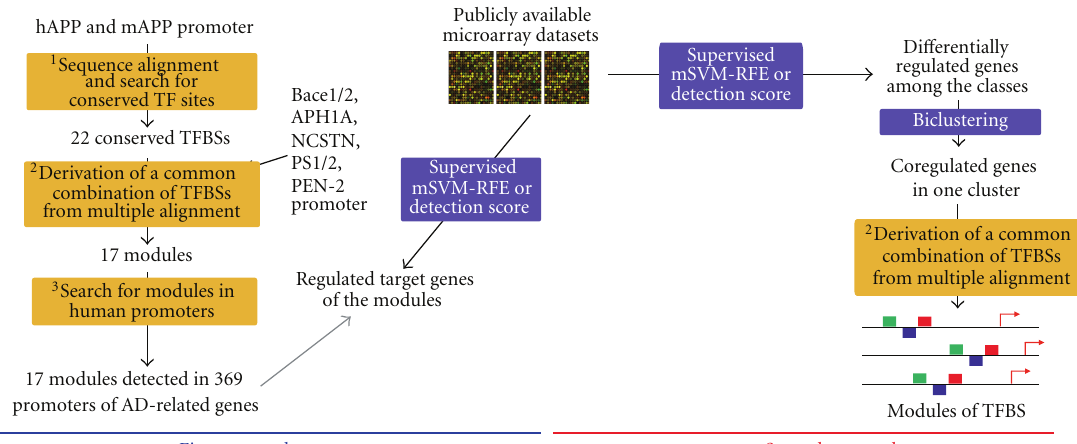
Figure 1: Workflow of bioinformatics analysis of promoter sequences and gene expression data to identify modules of TFBSs in AD-related genes. The workflow is divided into two parts, the first and second approach. The coloured boxes describe the methods which were used. The yellow boxes represent tools of the Genomatix Software ( 1 DiAlignTF, 2 FrameWorker, 3 ModelInspector), and the blue boxes indicate multivariate methods or filtering by illumina detection score. The beginning and the end of the arrow specify input and output of the methods, respectively. The grey arrow denotes the comparison of the target genes of the modules with genes di ff erentially regulated in microarray analyses. The scheme at the end of the second approach indicates a module composed of three TFBSs (blue, red, and green), which is common to three promoter sequences with transcription start site at the red